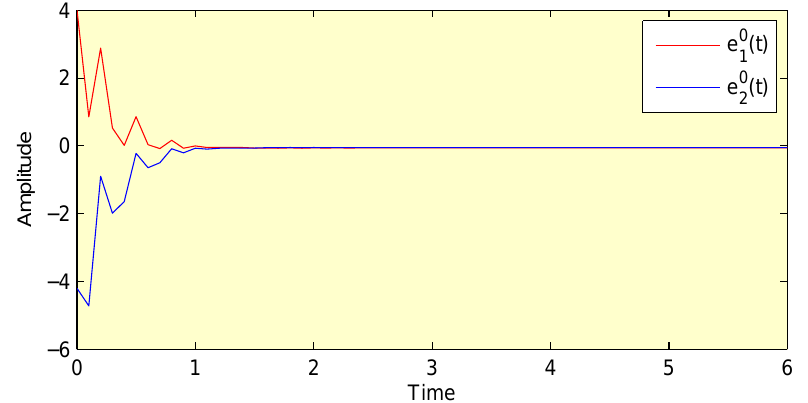
( t ) , (cid:101) 0 ( t ) of NN model (11) under con- 2 1